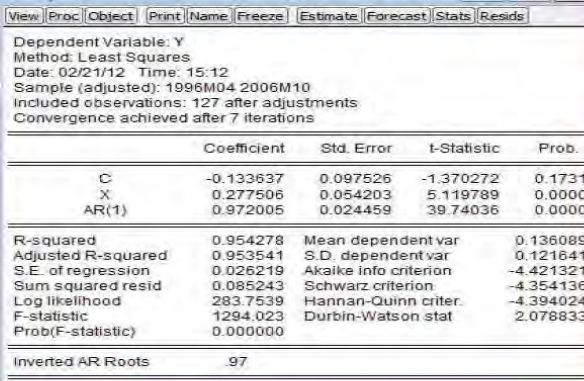
Dependent Variable: Y Method: Least Squares Date: 0212:1/12 Time: